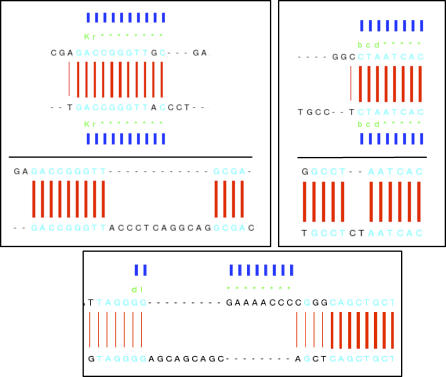
Snapshots from Alignments of Three CRMs: eve stripe 2 (Top Left), eve stripe1 (Top Right), and stumps_hbr_early (Bottom)In the top two panels, the alignment above was produced by Morphalign, and the alignment below it was produced by LAGAN (with gap opening penalty of 300).